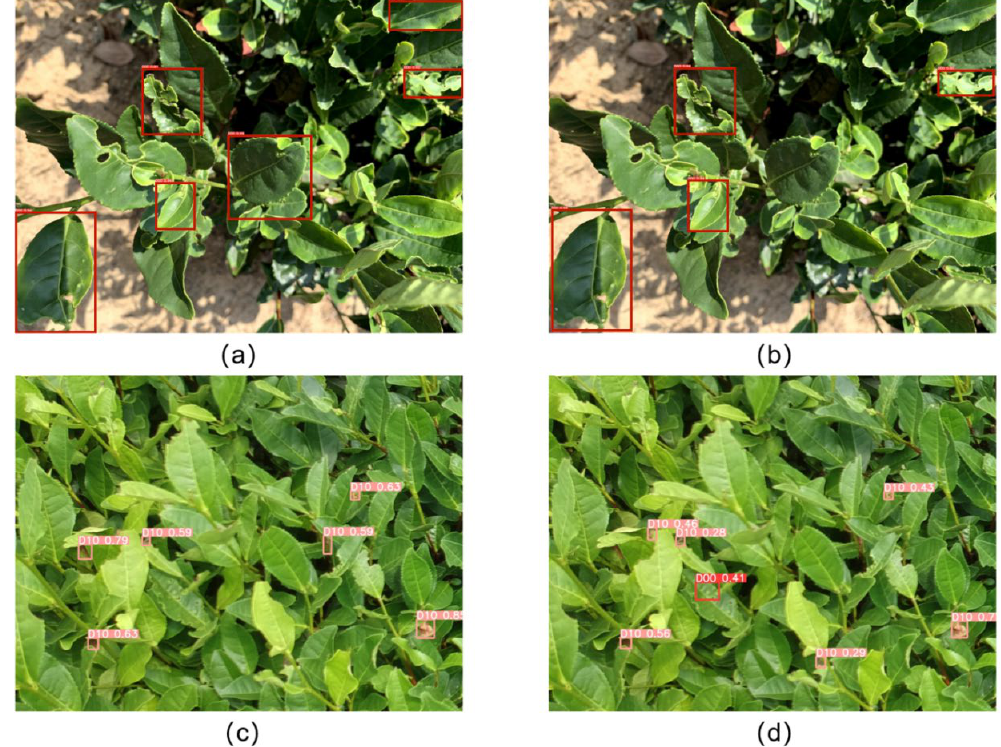
Figure 10. Comparison of model detection results. ( a ) YOLOv5's detection results. ( b ) YOLOv5-Tea’s detection results. ( c ) YOLOv5's detection results. ( d ) YOLOv5-Tea’s detection results. In Figure 10a, while the YOLOv5s correctly detected four green mirid bug infestation targets, it also failed to detected two green mirid bug infestation targets. In Figure 10b, YOLO-Tea correctly detected four targets of green mirid bug infestation. In Figure 10c, while YOLOv5s correctly detected four tea leaf blight targets, it failed to detect two tea leaf blight target and missed one green mirid bug target. In Figure 10d, YOLO-Tea cor- rectly detected six tea leaf blight disease targets and one green blind bug infestation target. 4. Discussion Due to various characteristics such as texture, shape, and color, diseases and insect pests of tea tree leaves are hard to accurately detect. The leaves of tea trees are also much smaller than those of other crops, which makes it difficult to detect disease on such a small target. The YOLOv5s model’s performance fell short of what was needed for our subse- quent study in the face of these issues. As a result, we enhanced the YOLOv5s model in numerous ways. First, as YOLOv5 is not able to focus effectively on small targets of tea leaves, we made our model more effective in focusing on tea leaflet targets by adding ACmix and CBAM. ACmix fuses convolution and self-attention, two powerful techniques in com- puter vision. The detection performance of models with ACmix is improved by 1.3%– 2.0%, in terms of 𝐴𝐴𝐴𝐴 0 . 5 , 𝐴𝐴𝐴𝐴 𝑇𝑇𝑇𝑇𝑇𝑇 , and 𝐴𝐴𝐴𝐴 𝐺𝐺𝐺𝐺𝑇𝑇 . However, ACmix has a large number of parameters. ACmix cannot be added to the model in large numbers in order to keep the model real time. CBAM is a lightweight module obtained by concatenating the